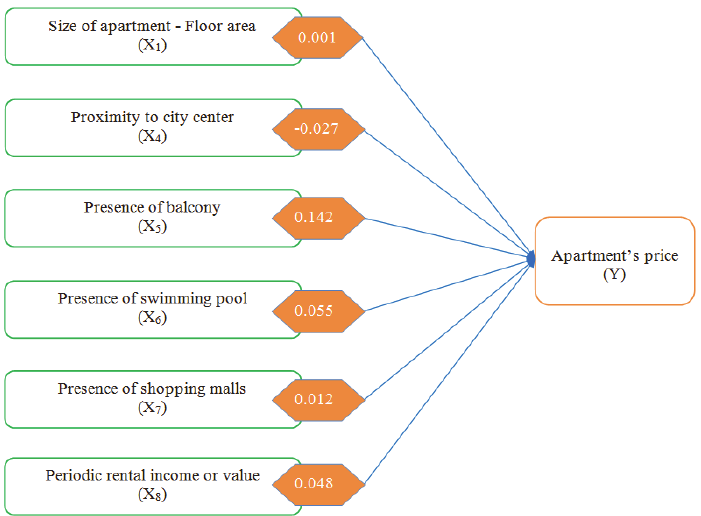
Fig. 2. Results of the coefficient